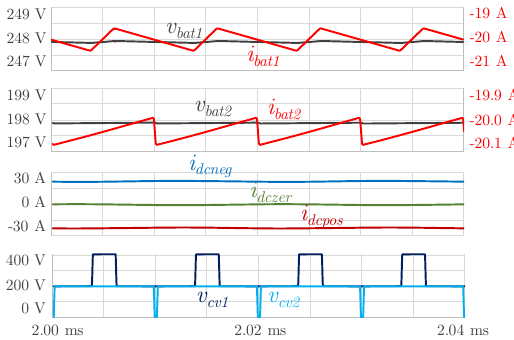
Figure 5. Simulation results of the V2G operation mode when EV1 and EV2 are discharging with a current of 20